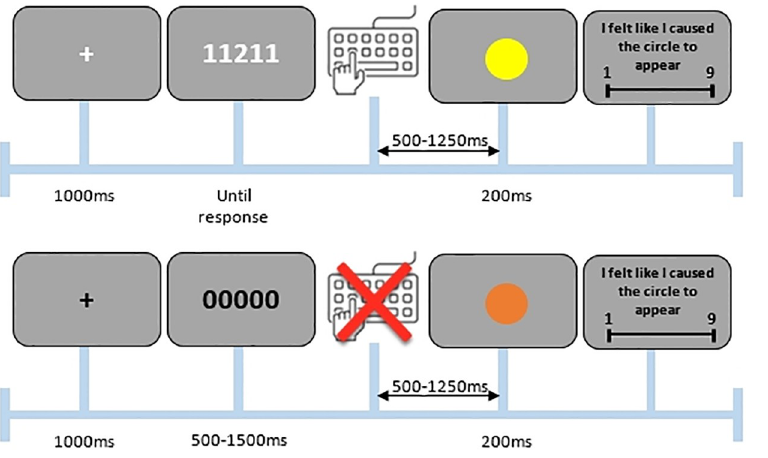
Fig 4. Example of an active (top) and passive (bottom) trial in Experiment